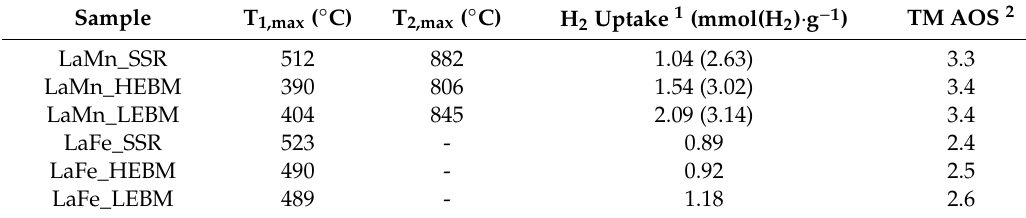
Table 2. H 2 -TPR results for LaMnO 3.15 and LaFeO 3